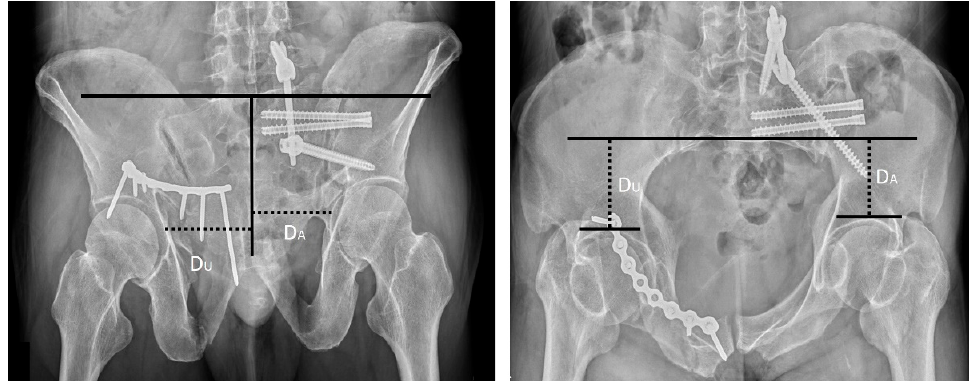
Figure 3. The inlet and outlet ratio are calculated (DA/DU) with the pelvic inlet and outlet views. The solid lines refer the reference lines, and the dashed lines refer measured lines. The Abbreviations: DA = distance of affected side; DU = distance of unaffected side.